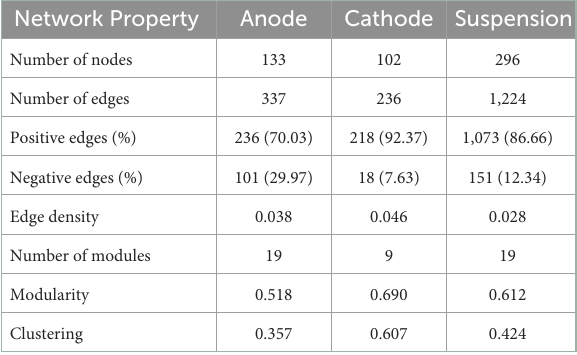
TABLE 1 A summary of the network properties for the anode, cathode, and suspension microbial